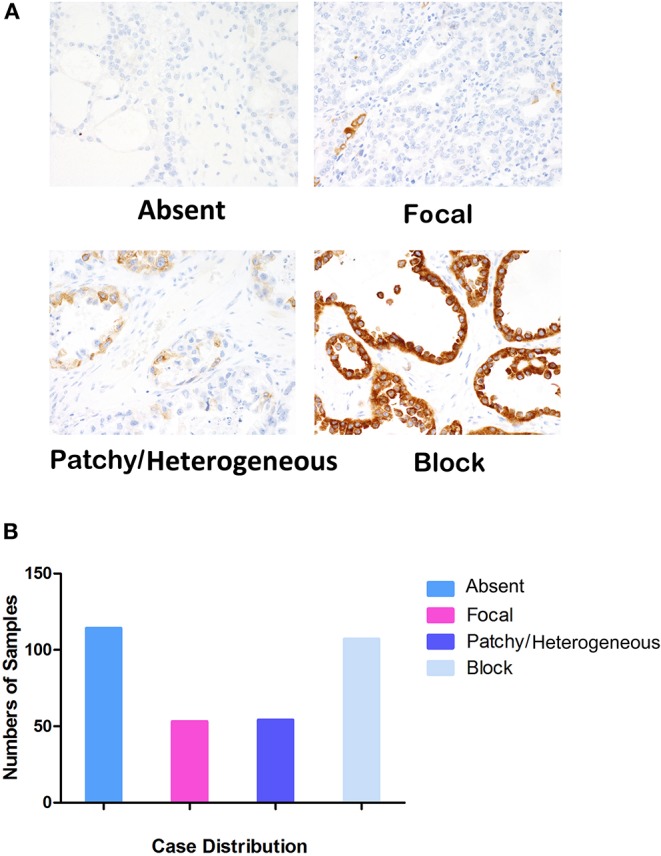
Evaluation standards of IGF2BP3 in IHC and case distribution. (A) Four levels of IGF2BP3 expression (×400). (B) Case distribution of different IGF2PB3 expression levels, Absent (N = 114), Focal (N = 53), Patchy/Heterogeneous (N = 54), and Block (N = 107).